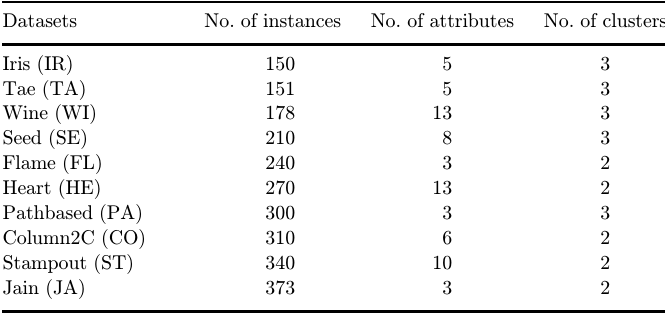
Table 1. The characteristics of the real-world and synthetic